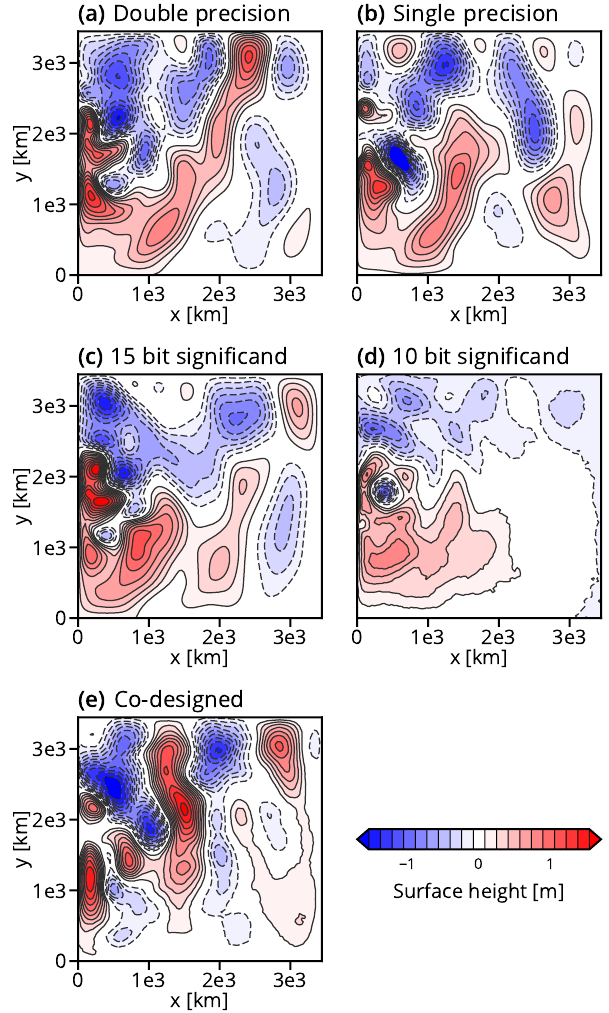
Figure 4. Snapshot of the surface height field for simulations of the shallow-water model. (a) Double-precision reference simulation, (b) single-precision simulation, (c) reduced precision with 15bit significand for all floating-point numbers, (d) reduced precision with 10bit significand for all floating-point numbers, and (e) simu- lation co-designed for half